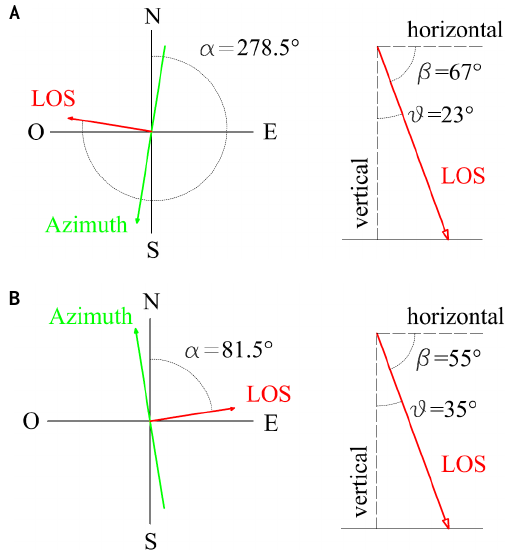
Fig. 5. Line Of Sight (LOS; red vector) geometrical characteristics for ERS1/2 in descending mode (A) and RADARSAT-1 (Standard Beam Mode 3) in ascending mode (B) . α , azimuth; θ , look angle (measured between LOS and vertical direction); β , tilt (measured between LOS and horizontal direction); green vector, azimuth